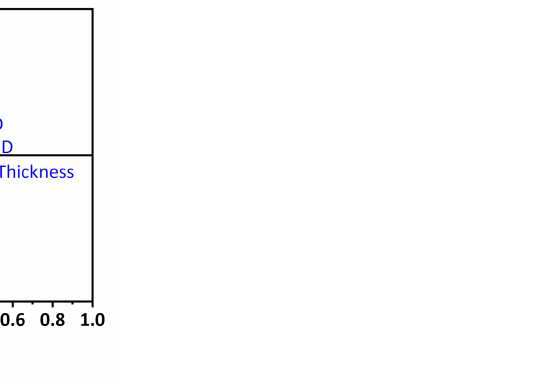
Figure 13. Principal component analysis 2D loading plot of various material, process, and as-built part properties.